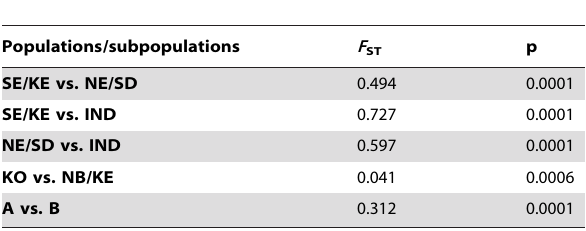
Table 1. F ST estimates with corresponding p values for pair- wise comparisons of the populations and subpopulations of L. donovani identified by STRUCTURE